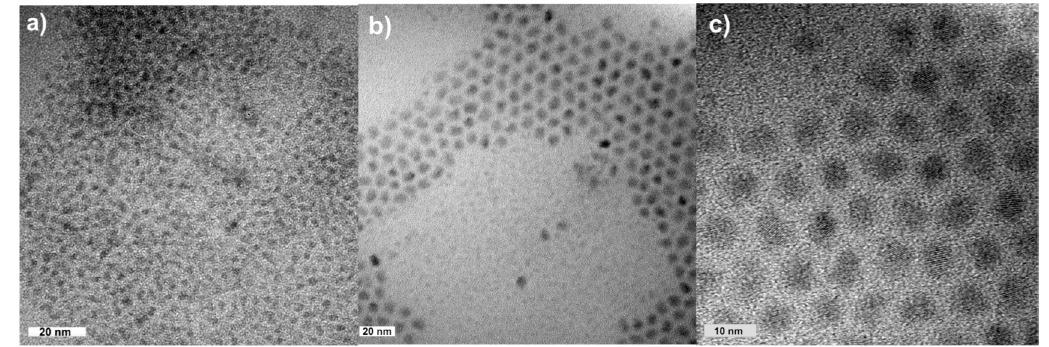
Figure 2. TEM images of ( a ) CIS QDs and ( b , c ) the corresponding CIS/ZnS QDs with different magnifications (synthesized using DDT as a capping ligand)[69]. magnifications (synthesized using DDT as a capping ligand)